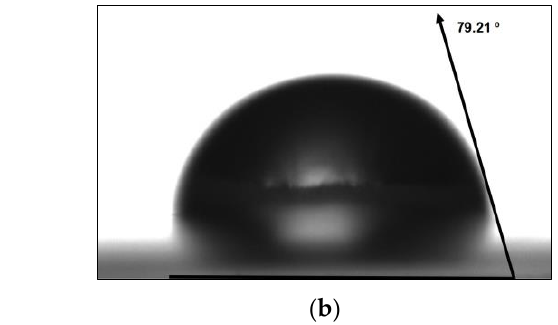
Figure 7. DSC thermograms of starch-based films: ( a ) native corn starch; ( b ) hydrolyzed corn starch under optimal conditions.